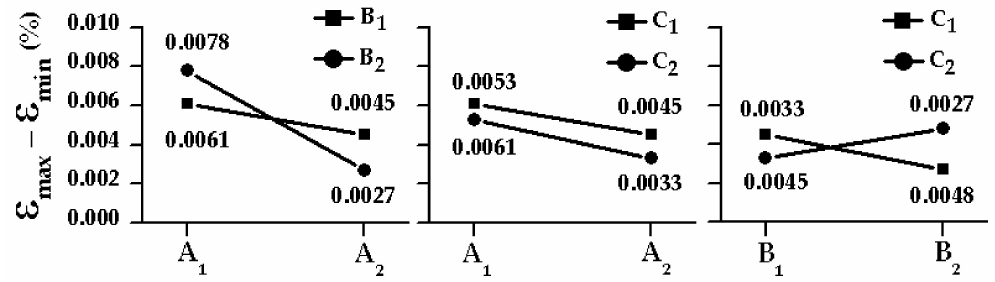
Figure 8. Interaction analysis for the two-way factorial design.